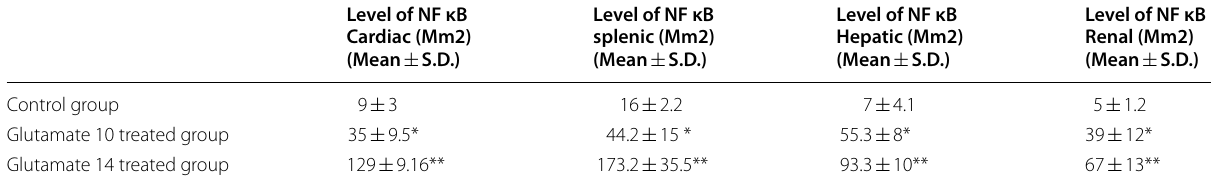
Table 1 Areas % of NF κB expression on cardiac, splenic, hepatic and renal of animals treated with monosodium glutamate dependent on